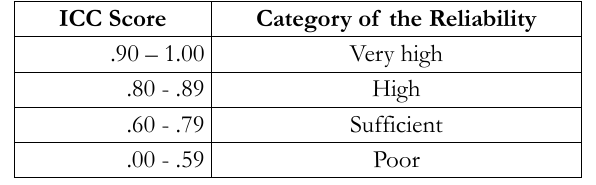
Table 2. Interpretation of ICC Score